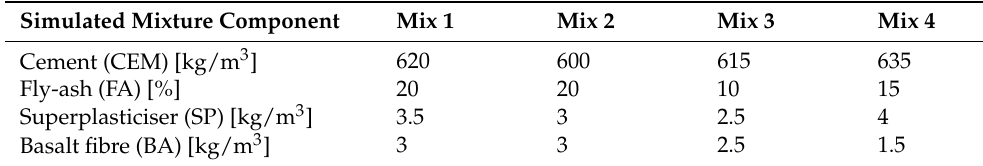
Table 7. Simulated mix composition of mortar.